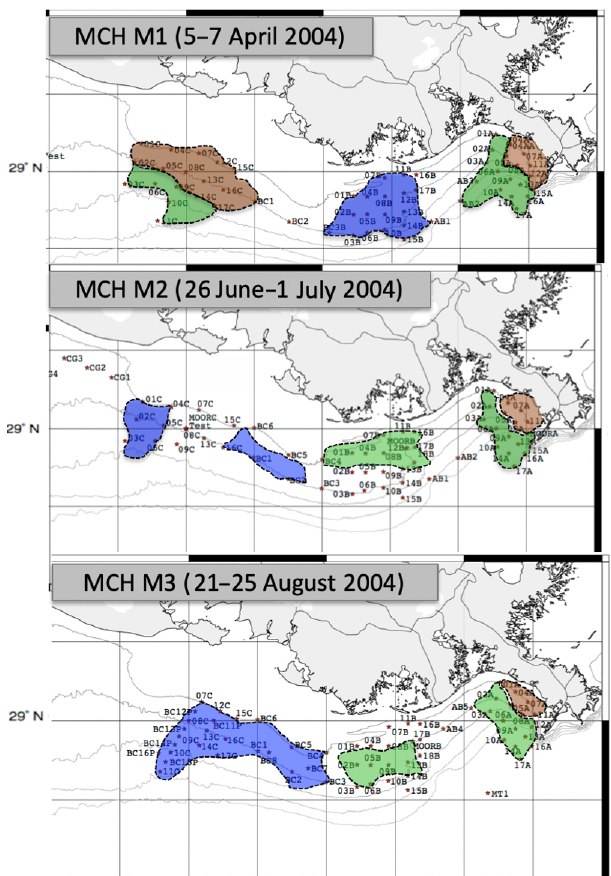
Figure 8. Distribution of the three zones during cruises MCH M1– M3 based on salinity data (Lahiry, 2007). Areas identified as brown, green or blue zones are shaded